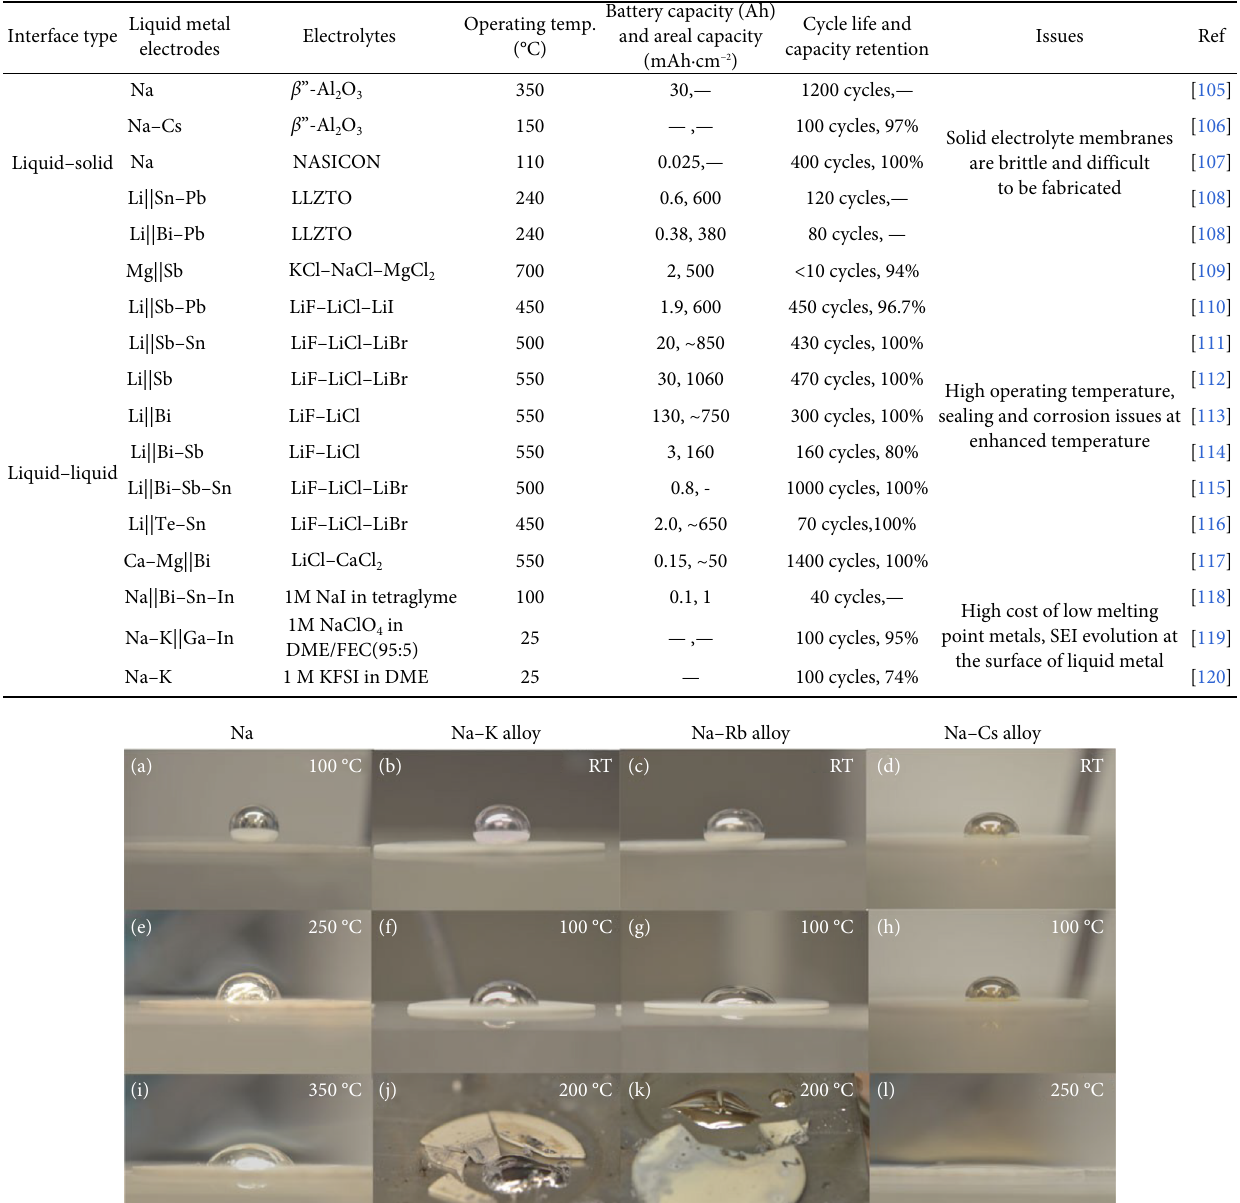
Table 4 The applications and challenges of liquid metal electrode batteries Liquid metal Interface type electrodes